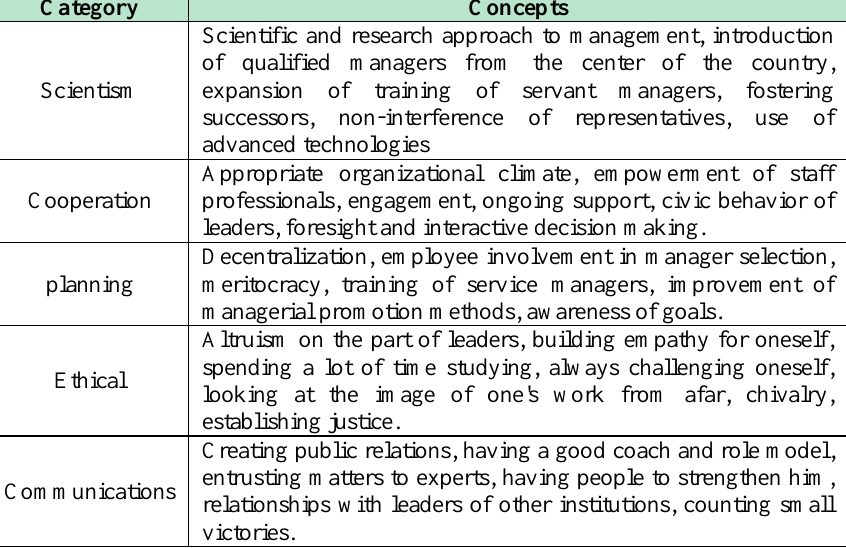
Table 4: Open coding of server leadership executive